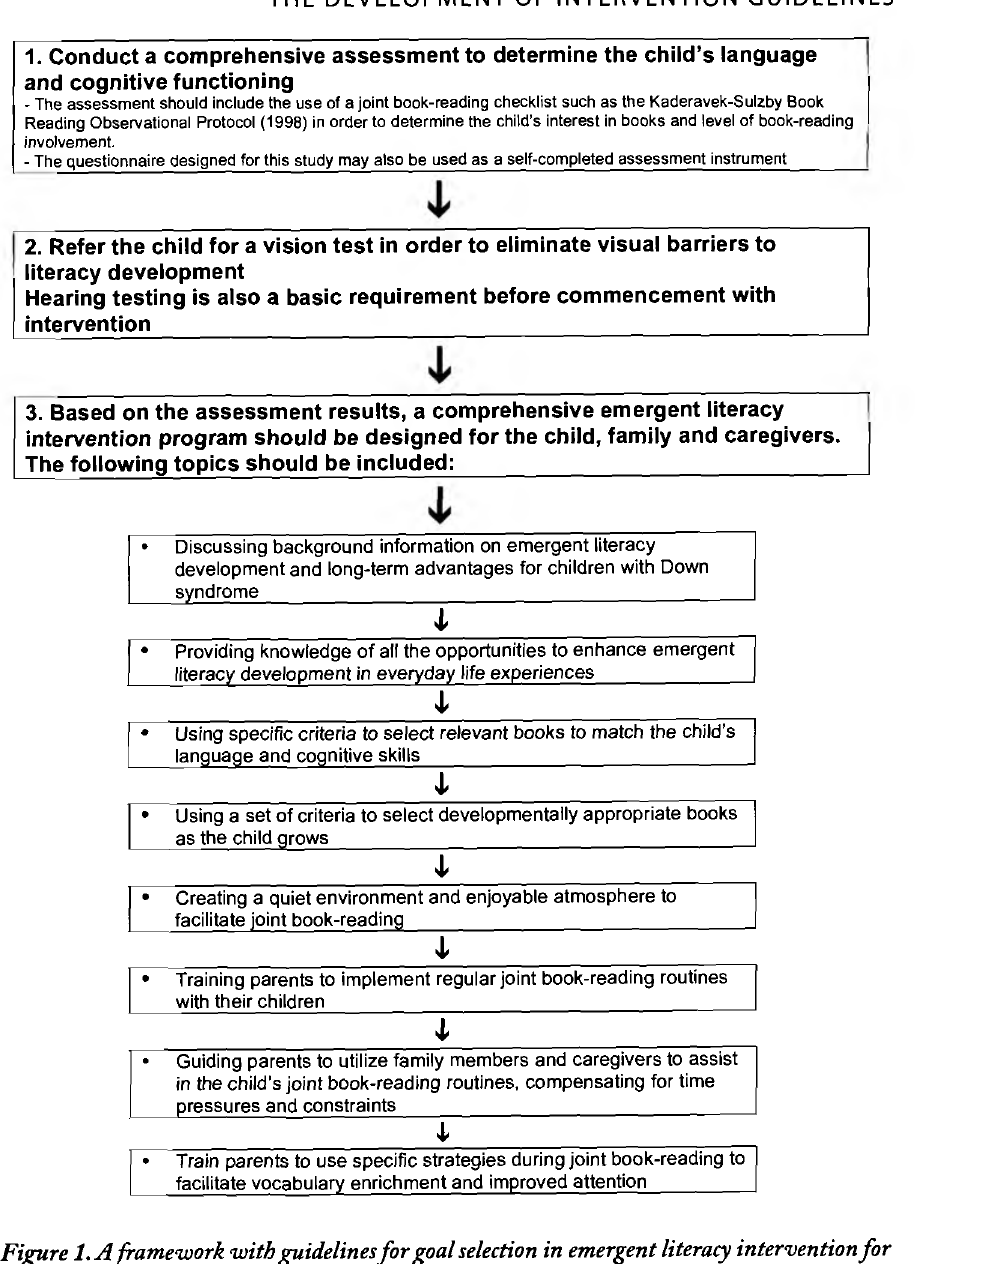
Figure 1. A framework with guidelinesfor goal selection in emergent literacy intervention for young children with Down